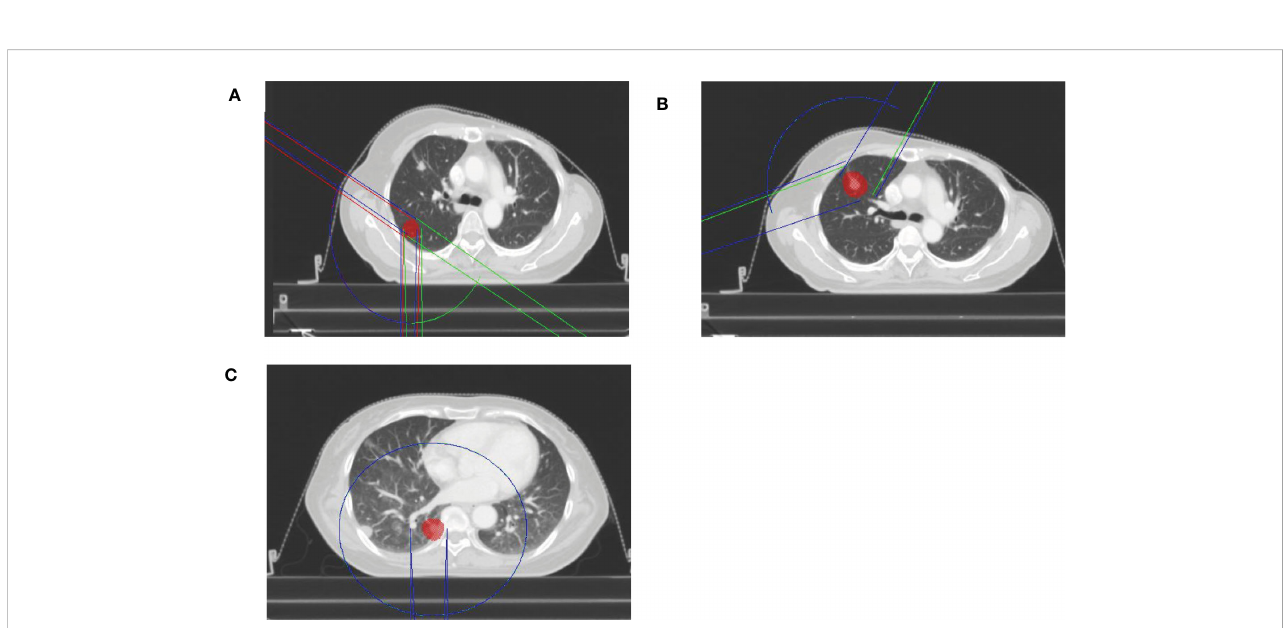
FIGURE 1 The arcs for right lung for FFF beams and FF beams. (A) the lower region of the lung. (B) the upper region of the lung. (C) the midline of the body.